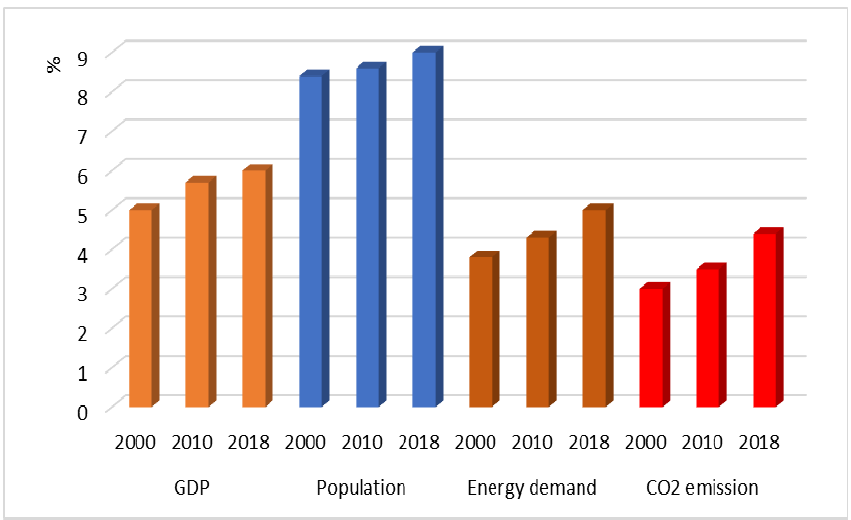
Figure 1. Share of Southeast Asia in global economic indicators, energy consumption and CO 2 emissions [5].